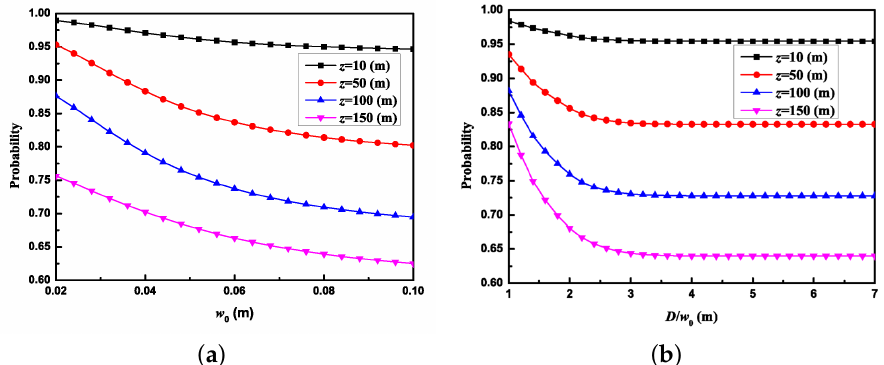
Figure 3. The normalized transmitting probability of the signal vortex modes versus ( a ) initial beam width w 0 and ( b ) received diameter D with w 0 = 0.05 m for different values of propagation distance z